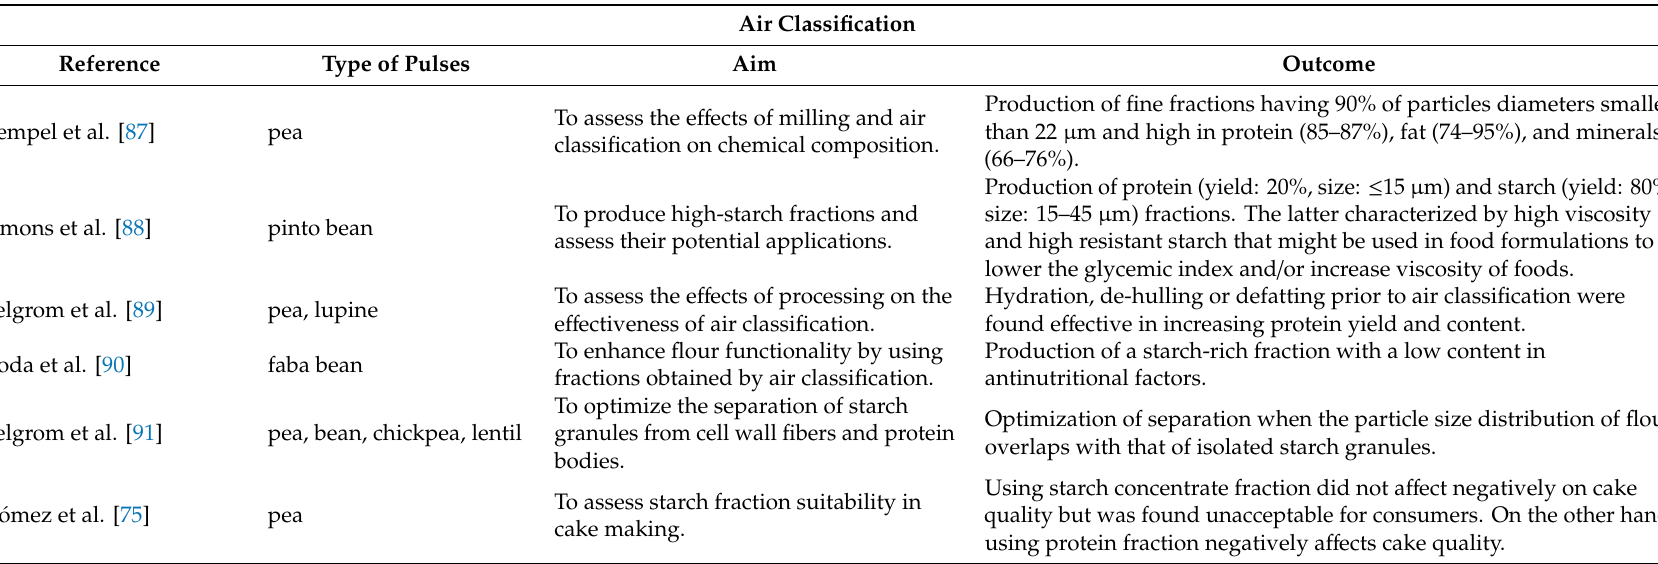
Table 3. Aim and main results of the most recent studies on the (bio)-technological approaches applied to